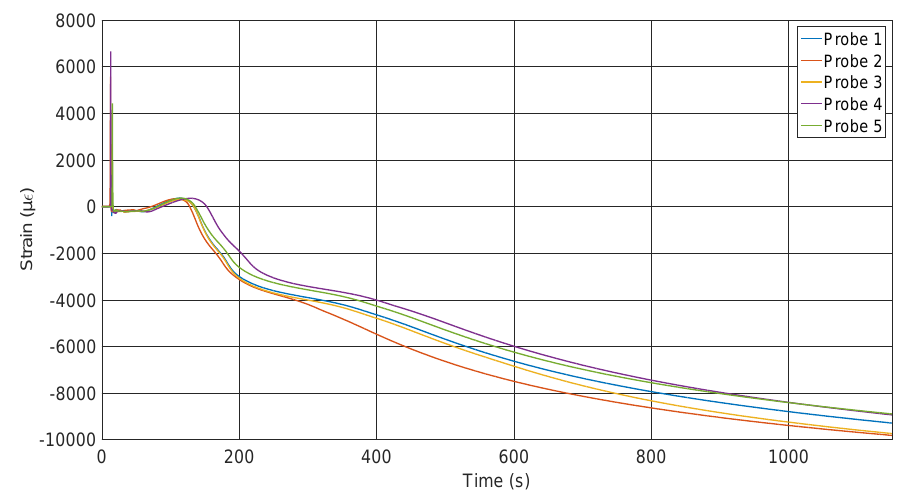
Figure 9. Strain curves during the solidification process measured by FBGs across the flow direction of the